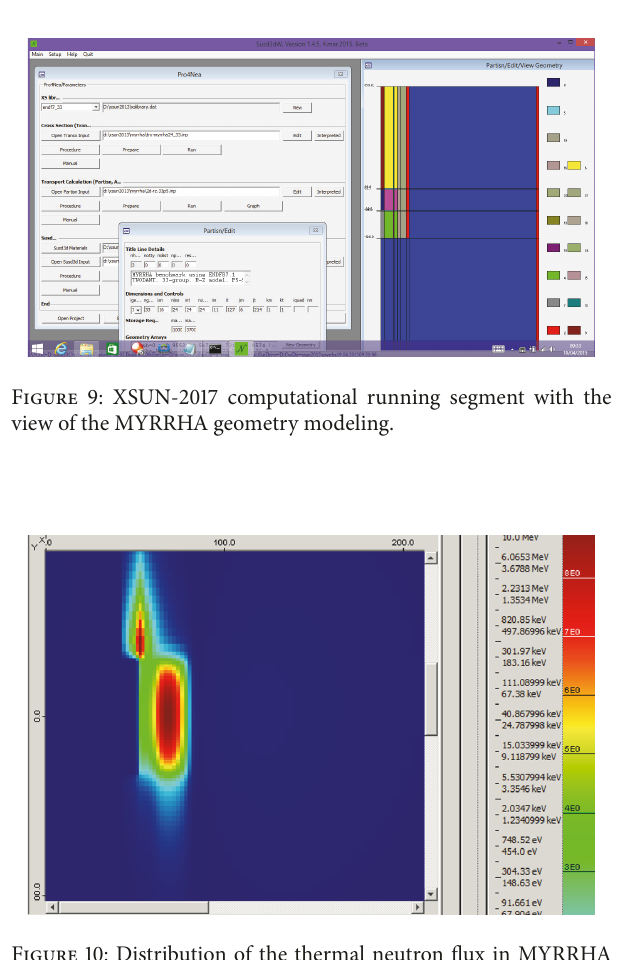
Figure 12: Distribution of ∼ 3MeV neutron flux in MYRRHA calculated using the PARTISN